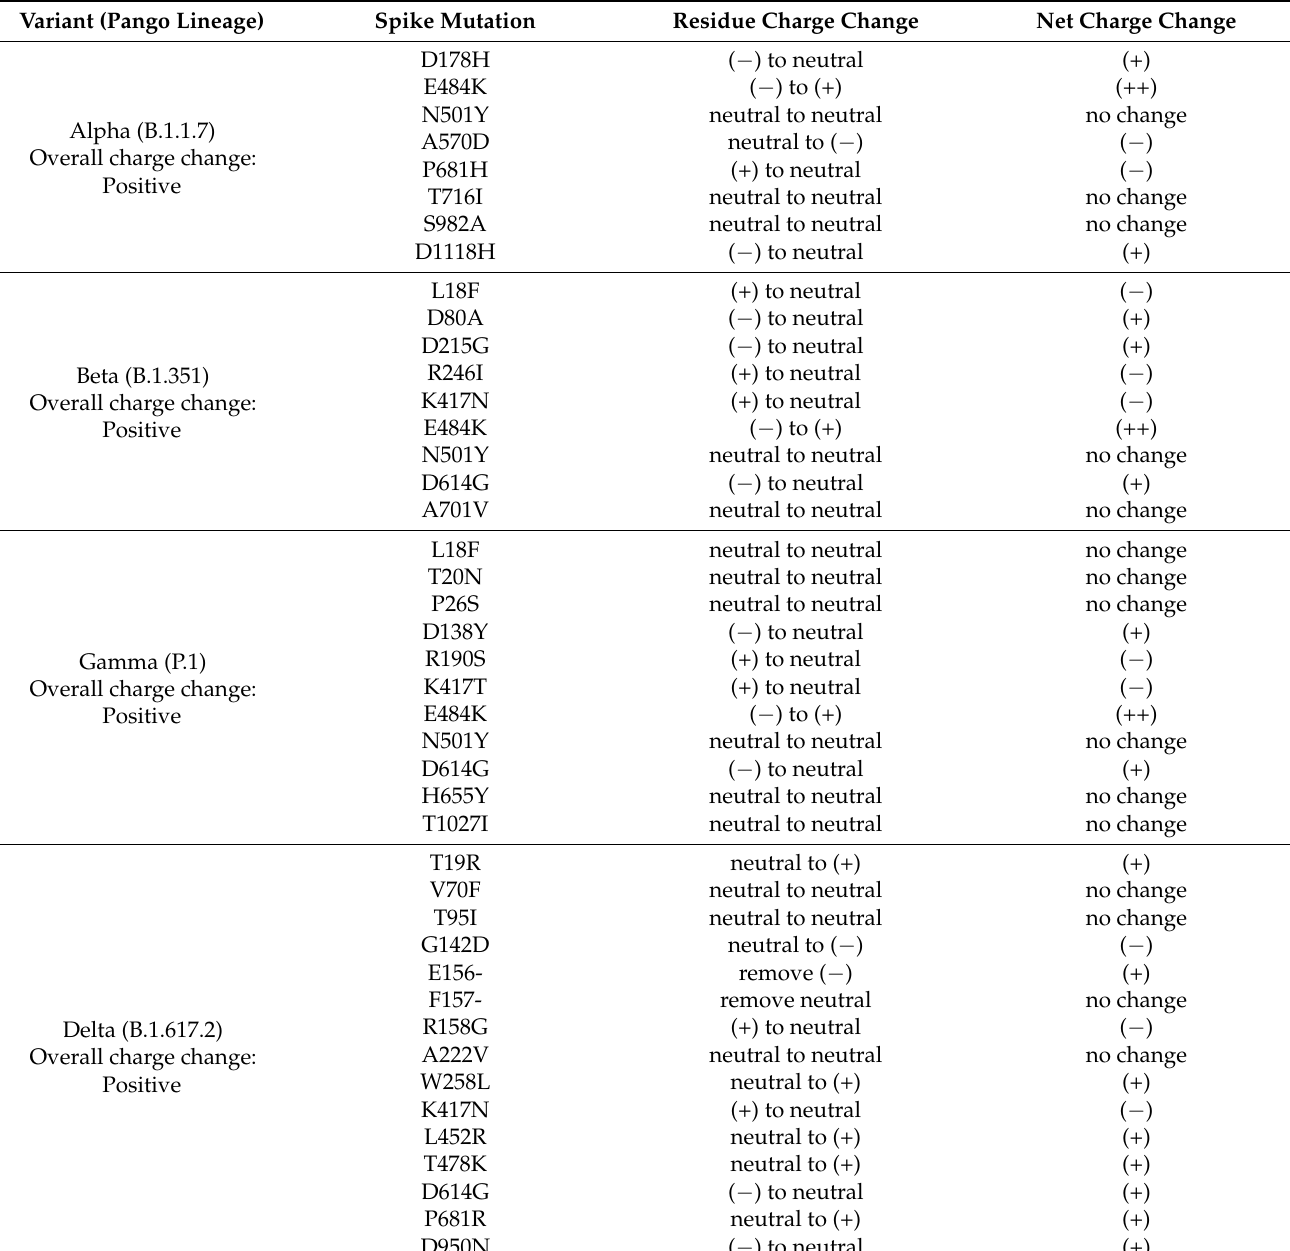
Table 4. SARS-CoV-2 spike protein sequence mutations by variant of